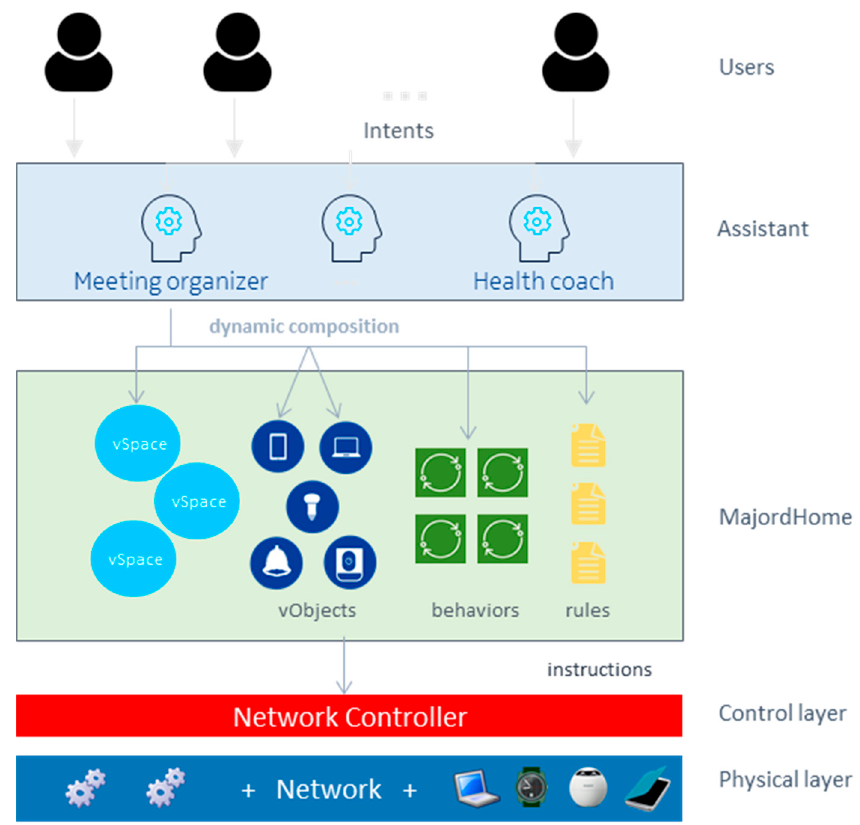
Figure 12. Layered composition of the Future Spaces solution, from user-intents to physical network configuration.